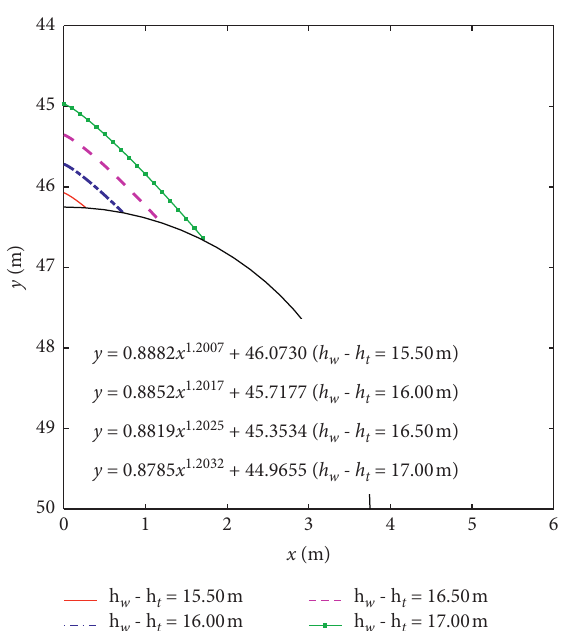
Figure 10: Effect of hydraulic head difference ( h sat on